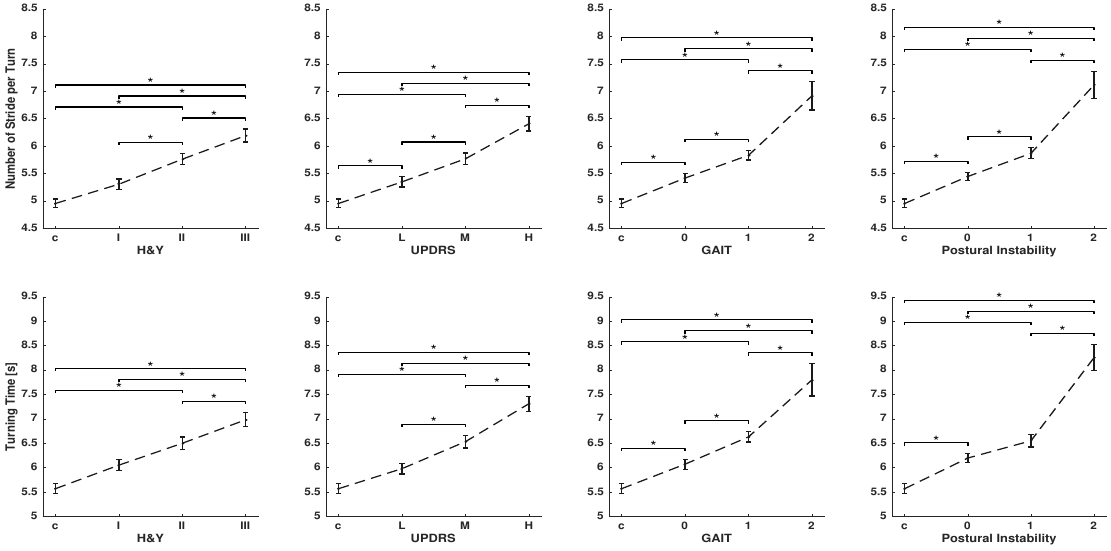
Figure 2. Global parameters characterizing turning: number of strides per-turn and turning time were calculated for controls and PD patients grouped according to H&Y disease stage, UPDRS-III total score, and the single items, gait and postural instability of the UPDRS-III. Group data are displayed as mean ± SEM and were compared using one-way ANOVA followed by Bonferroni’s post hoc test, where * indicates p <